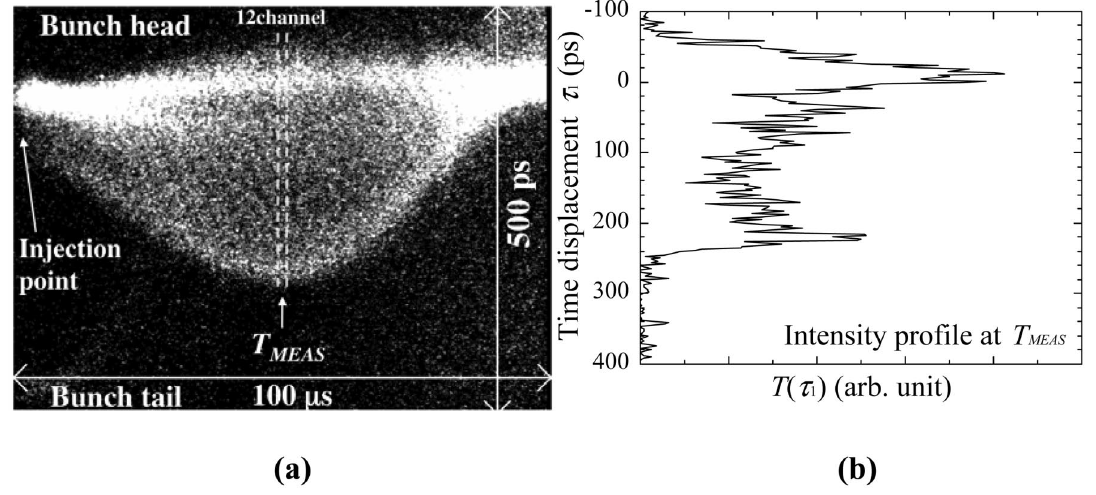
FIG. 3. Streak camera image (accumulation of 50 shots). (a) shows the longitudinal transient of the injected beam, and (b) shows the (cid:5) at T . The pulse width is 0.25 ns and the rf voltage is 130 kV. The bunch charge is approximately 0.03 nC. intensity profile T (cid:4) (cid:1) 1 MEAS The broken lines in (a) indicate the slice width (about 1 : 9 (cid:5) s ) for (b).